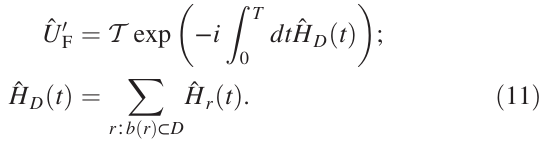
FIG. 2. Schematic definition of the edge operator with a MBL bulk. Up to an exponentially small error, the edge operator is contained within a distance of 2 ξ from the edge, where ξ denotes the bulk localization